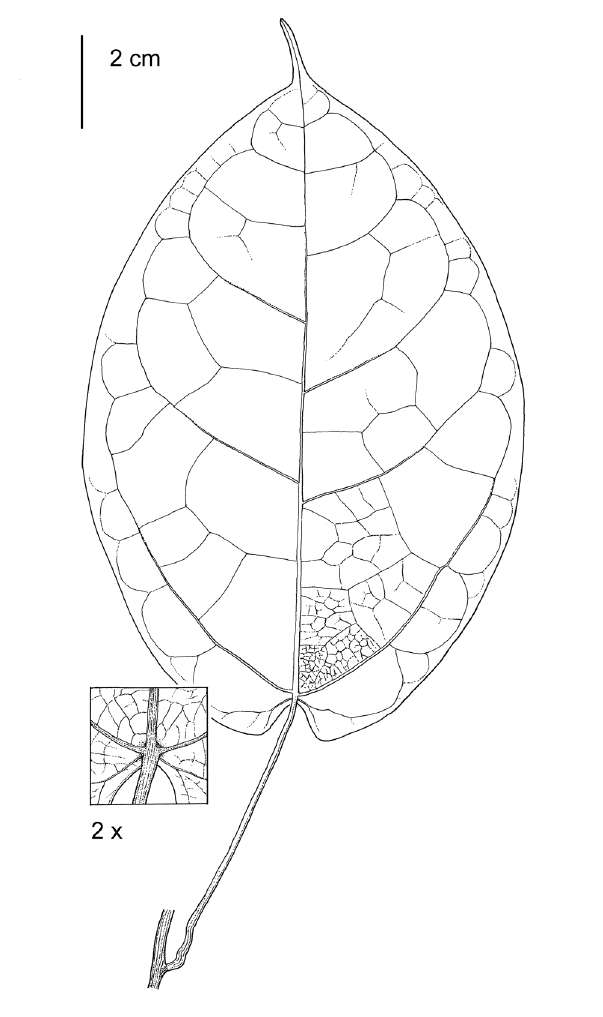
Figure 9 – Rhigiocarya leonensis . Leaf with detail of leaf base beneath. Drawn by Marjolein